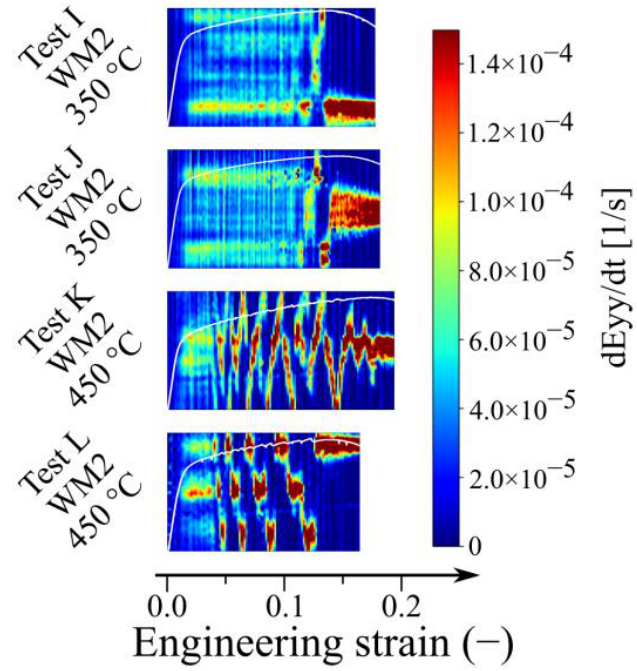
Figure 6. Strain rate maps of tests performed on the GTAW material (WM2) at 350 ◦ C (Test I and J) and at 450 ◦ C (Test K and L). The engineering stress–strain curves of each test are overlaid on the strain rate maps in white.